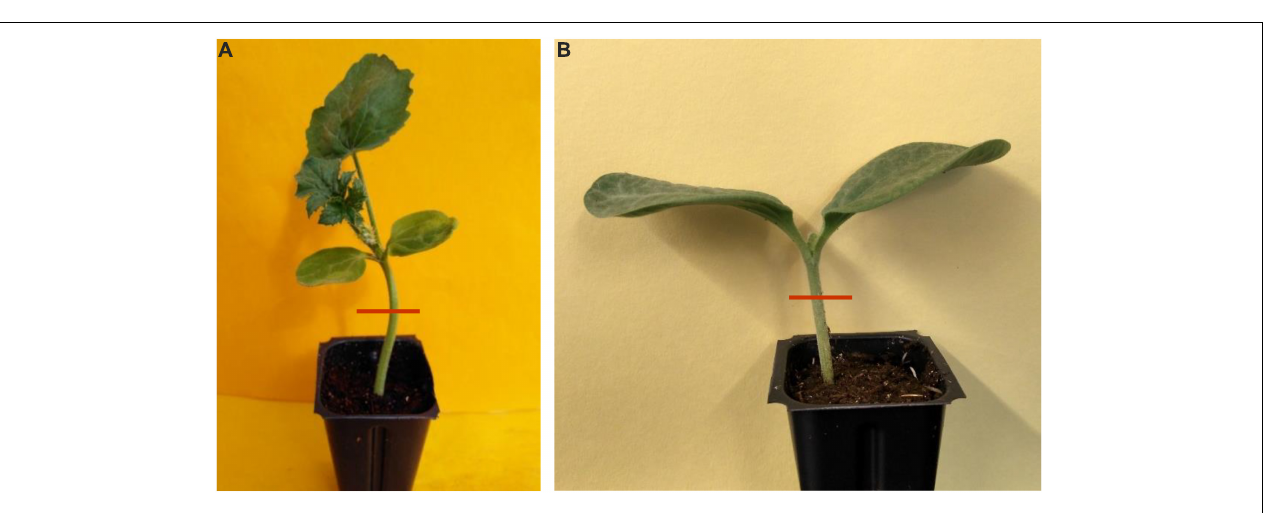
University (WWU) SEM laboratory in Bellingham, WA, which is located about 45 km north of WSU